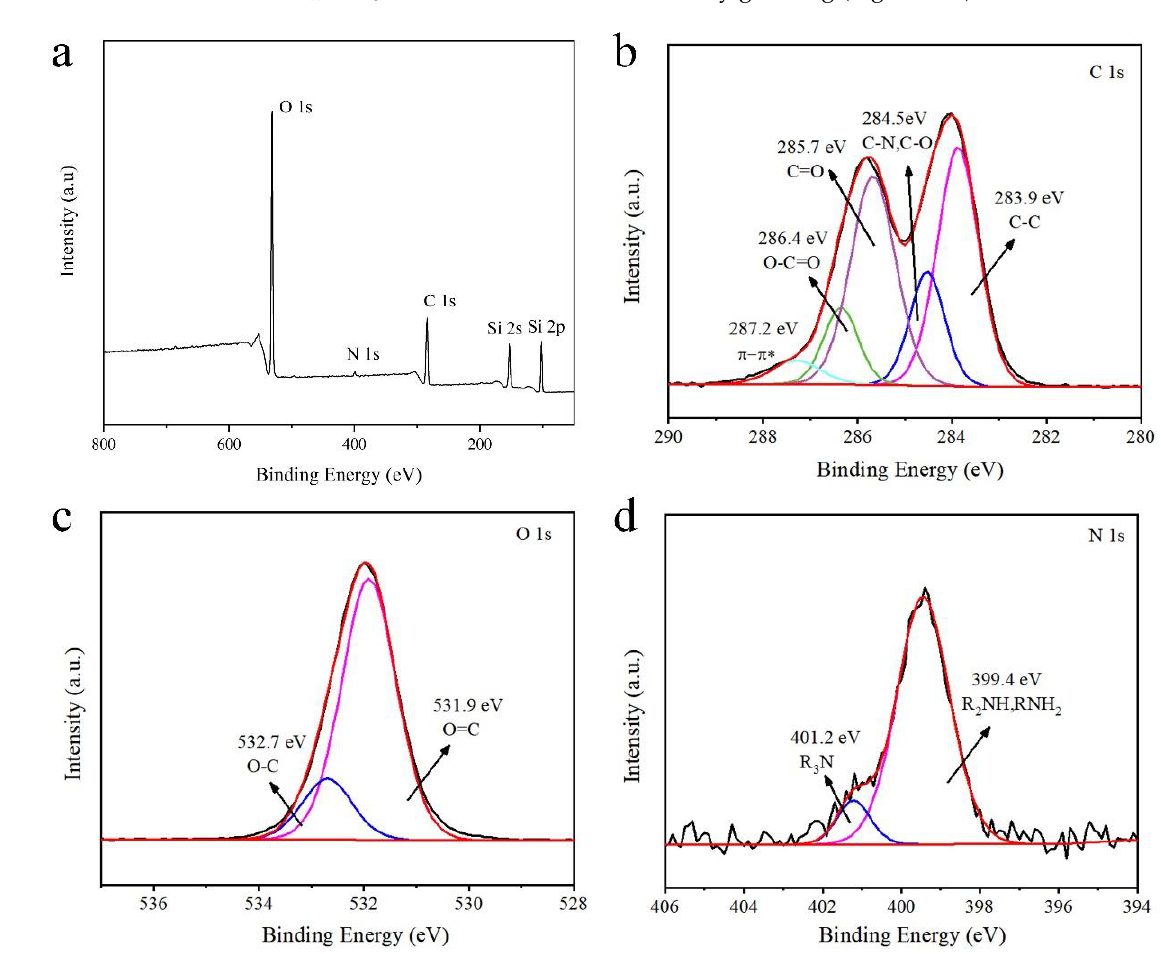
Figure 3. XPS analyses of SiO 2 –CH 3 –CALB@PDA. ( a ) Survey scan, ( b ) C 1s, ( c ) O 1s and ( d ) N